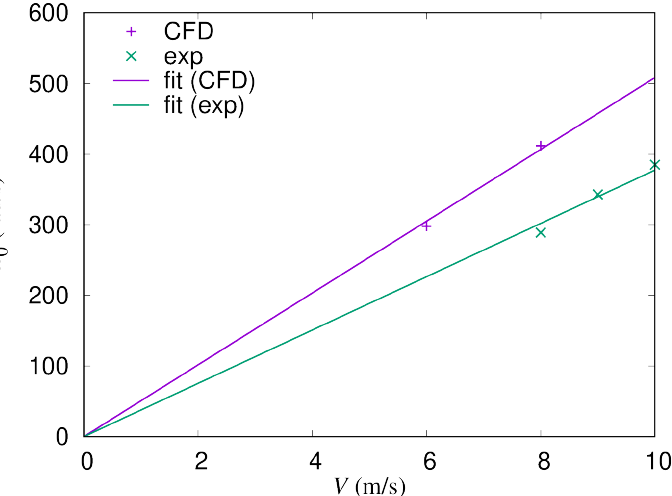
Figure A2. ω 0 from Figure 2 of Ref. [14], Figure 3 of Ref. [8], and their fitting curves are shown. Third, the torque dependence on the azimuthal angle obtained by the CFD is shown. A rotor with three blades, of which dimensions are the same as described in Section 3.1, was placed in the flow field of which upstream flow velocity was 10 m/s. The modulation of the torque, expressed by Equation (6), tries to simulate this dependence. Figure A3 shows the averaged torques over the 16th–20th rotations of the CFD data, which was not published previously. For n = 3, the torque is the summation of torques on all blades of the rotor. The torque for a single blade has its maximum at ψ (cid:39) π /2. In the downstream half, the torque on a single blade becomes negative in the CFD, although it is set to be zero in Equation (6) for